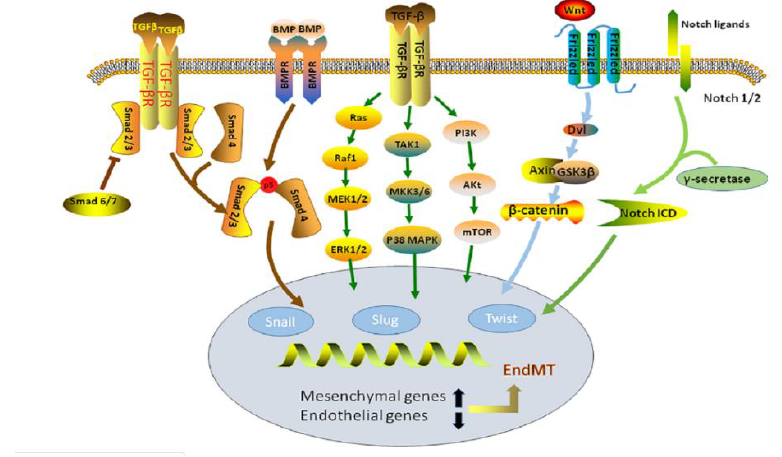
Figure 10. Representation of the TGF- β , BMP, and WNT signaling pathways. The processes that lead to endMT through each pathway are displayed [126].